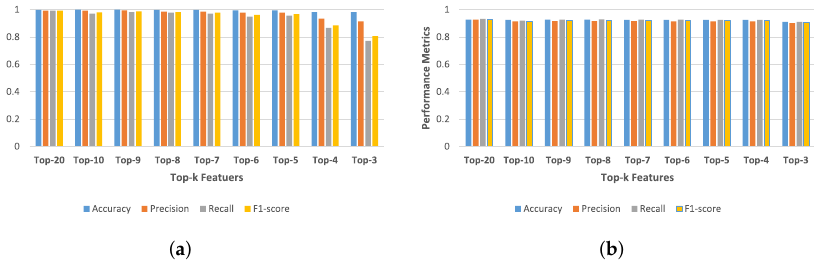
Figure 2. Performance of multi-class classifier trained by top-k selected features: ( a ) CICIDS2017; ( b ) CICDDOS2019.